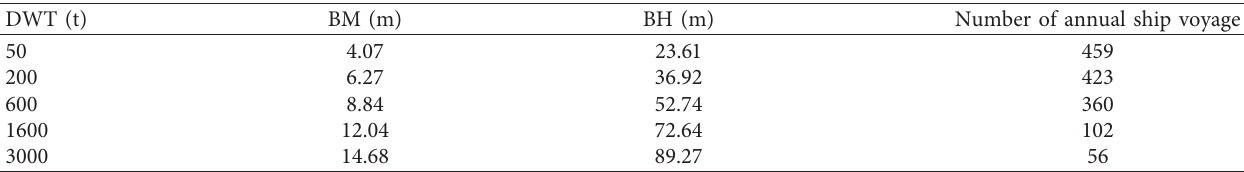
Table 2: Equivalent ship parameters in the assessed